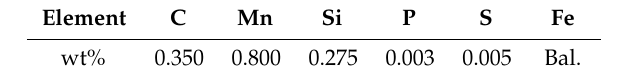
Table 1. Chemical composition of AISI 1035 carbon steel material.